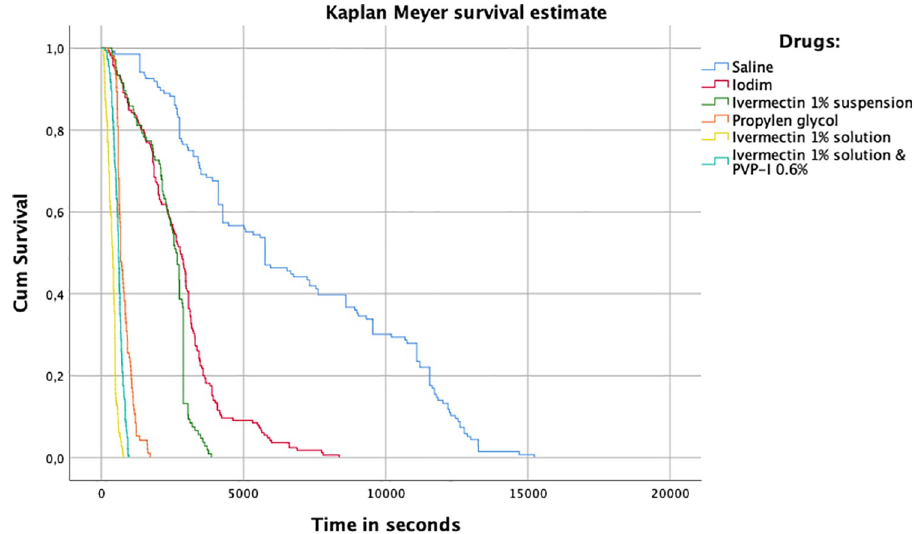
Fig 1. Kaplan Meyer survival estimates. The graph shows the survival curves of all the preparations